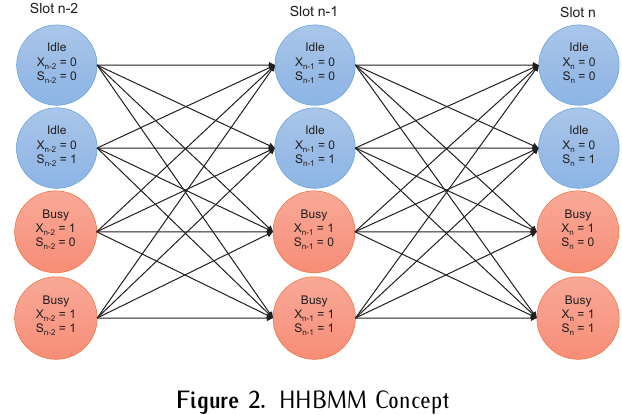
Figure 2. HHBMM Concept